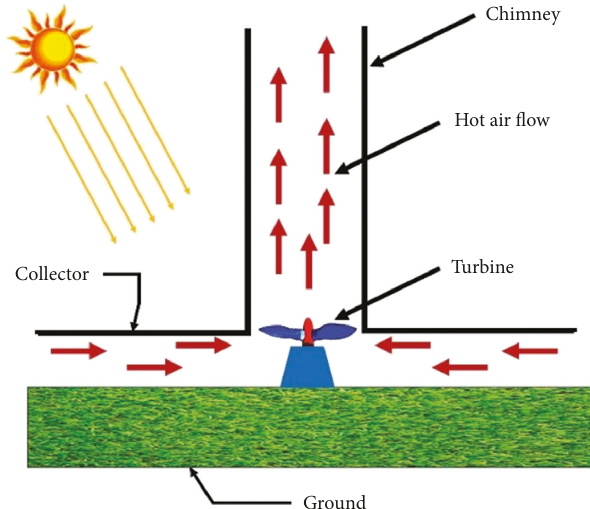
Figure 1: Schema of a solar chimney power